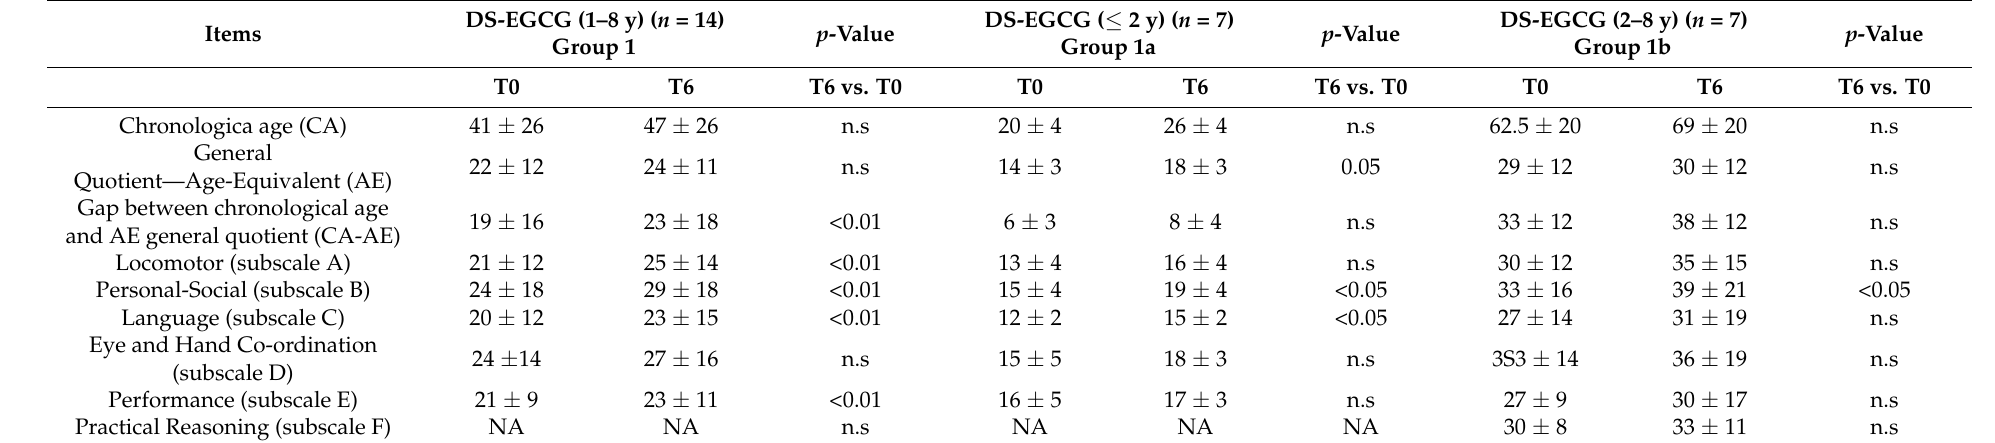
Table 4. Results of the GMDS-ER analysis in EGCG-treated DS children.